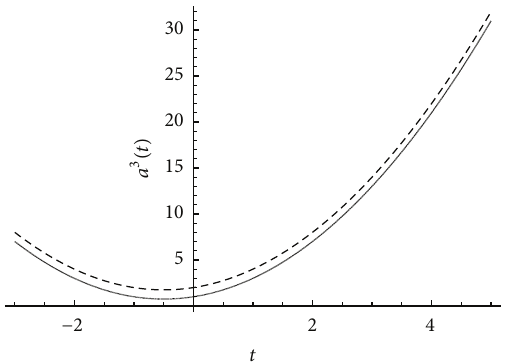
Figure 2: Dynamics of the deformed phase space model for the case 𝜔 󸀠2 = 0 or equivalently 𝛽 = 2𝜔 . We can see that the behaviour is the same in the “ C-frame ” and in the “ NC-frame